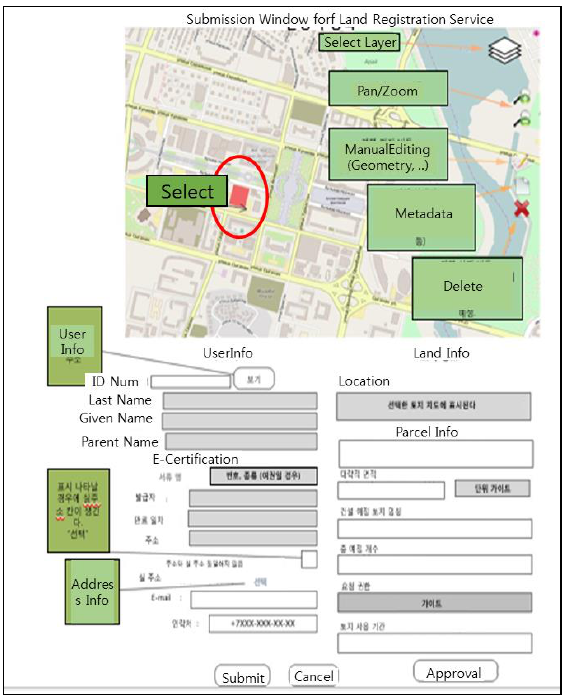
Figure 6. Kazakhstan NGIS Portal – Land